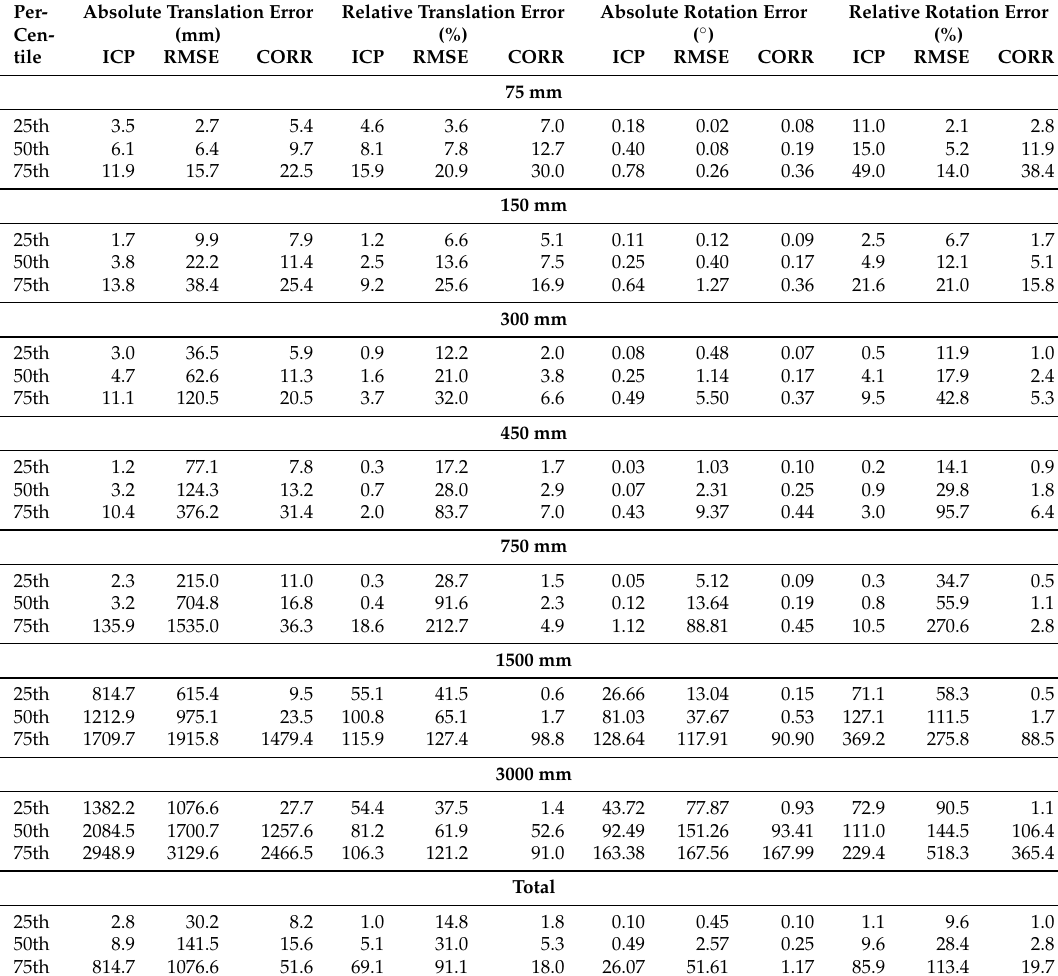
Table 2. The translation and rotation errors of scan matching by the ICP, RMSE and CORR